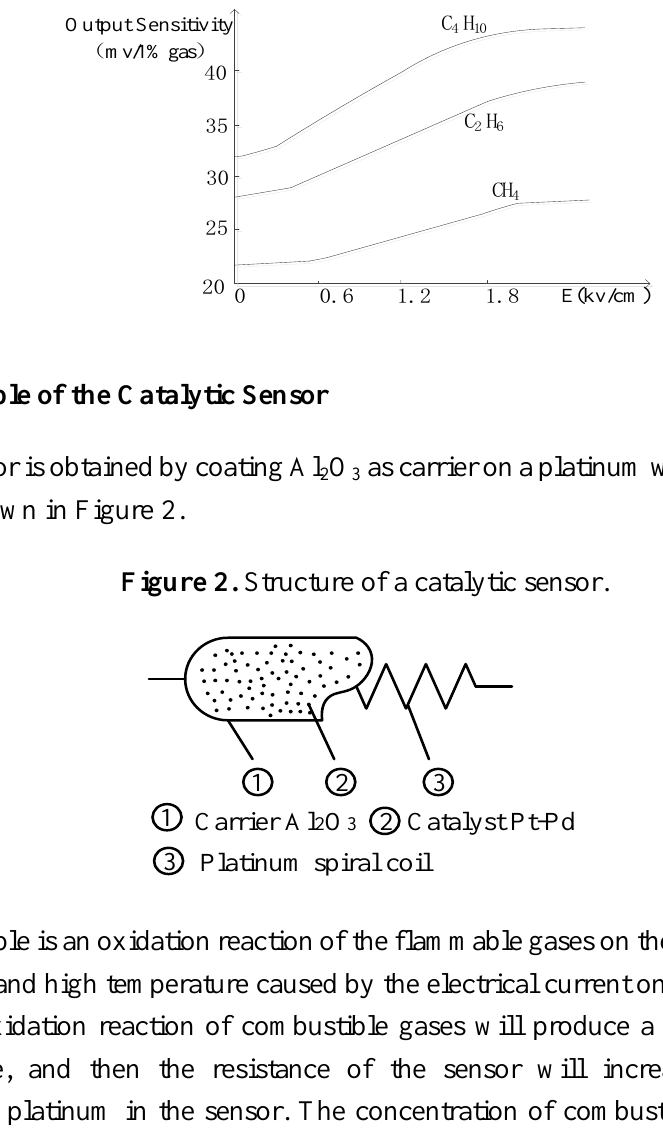
Figure 1. Electric field effects on three different gases.